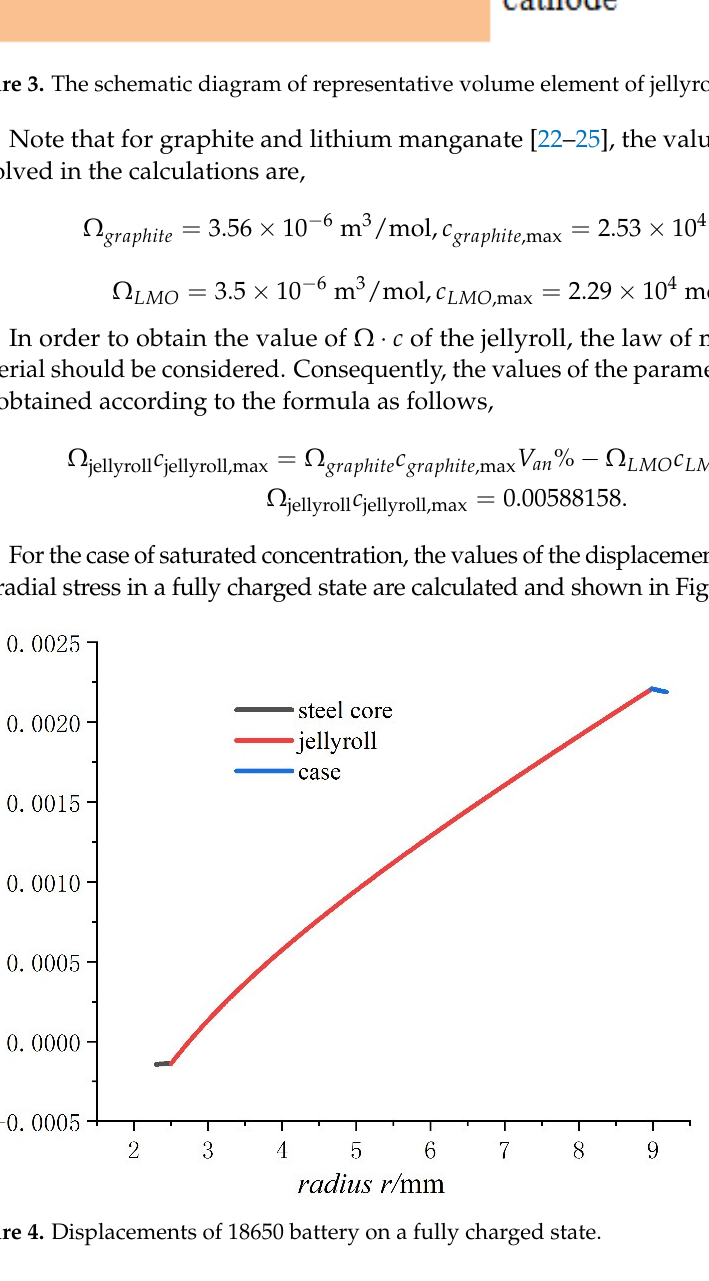
Figure 5. Radial stresses of 18650 battery on a fully charged state.